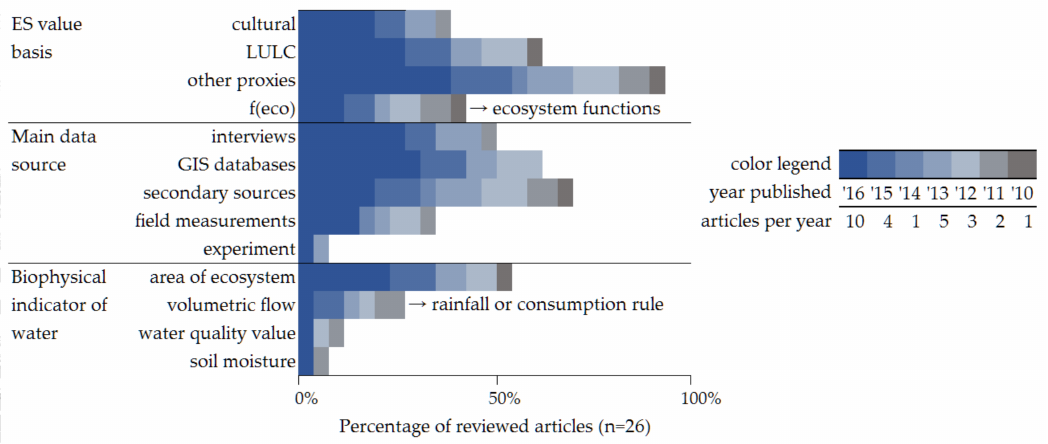
Figure 1. Trends in data foundations for assessing ES in mining